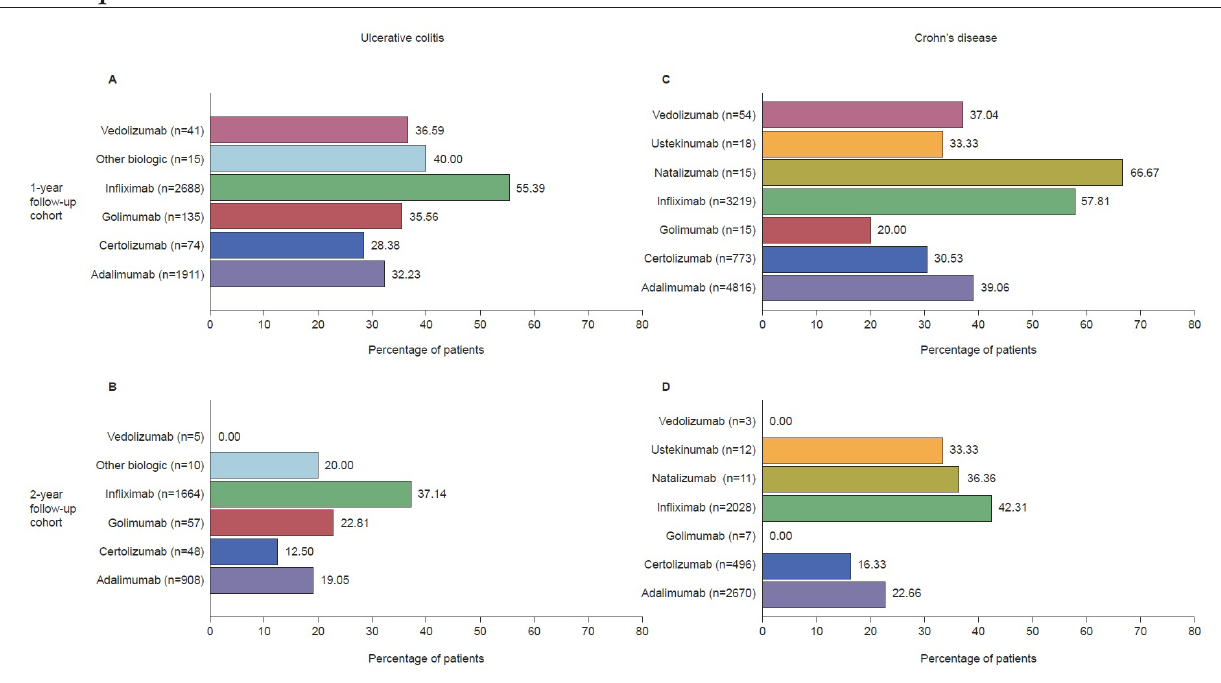
Figure 4. Proportion of Patients with UC and CD Who Received the Same Biologic Throughout